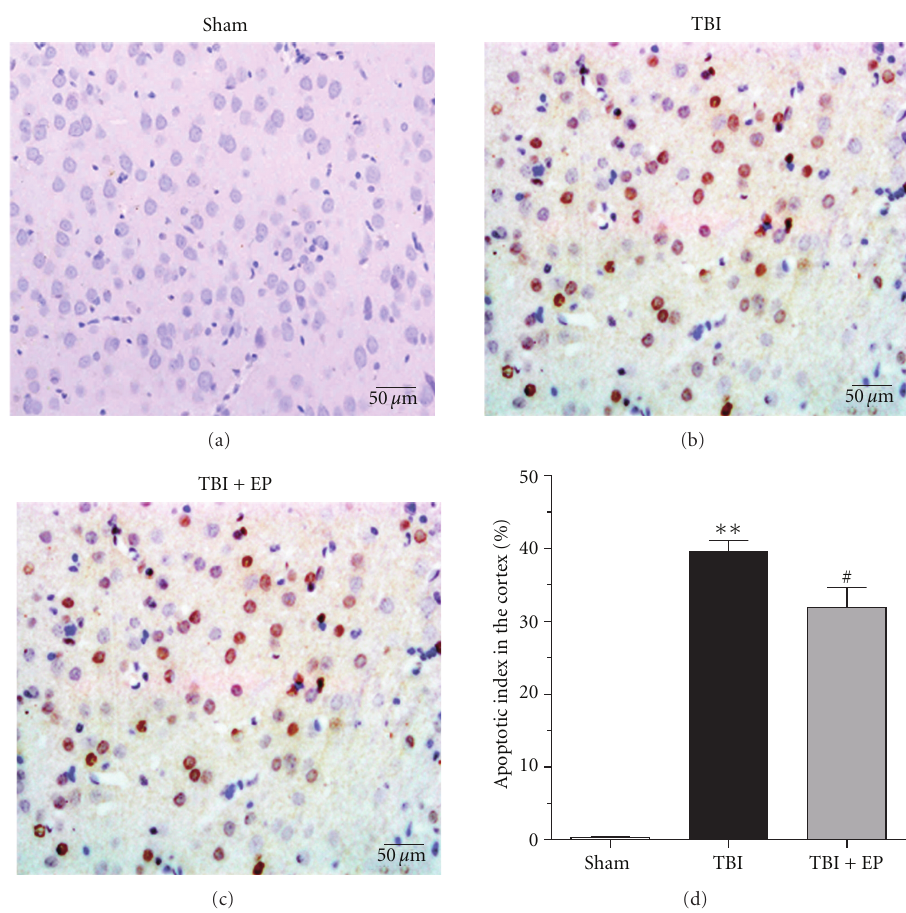
Figure 9: TUNEL immunohistochemistry staining of the injured cortex in Sham group, TBI group, and TBI + EP group. (a) Sham group rats showed few TUNEL apoptotic cells; (b) TBI group rats showed more TUNEL apoptotic cells stained as brown; (c) TBI + EP group rats showed less TUNEL apoptotic cells than TBI group (scale bars, 50 μ m). (d) EP administration significantly decreased the apoptotic index in rat injured brain following TBI. Bars represent as mean ± SEM; n = 6, each group; ∗∗ P < . 01 versus Sham group, # P < . 05 versus TBI